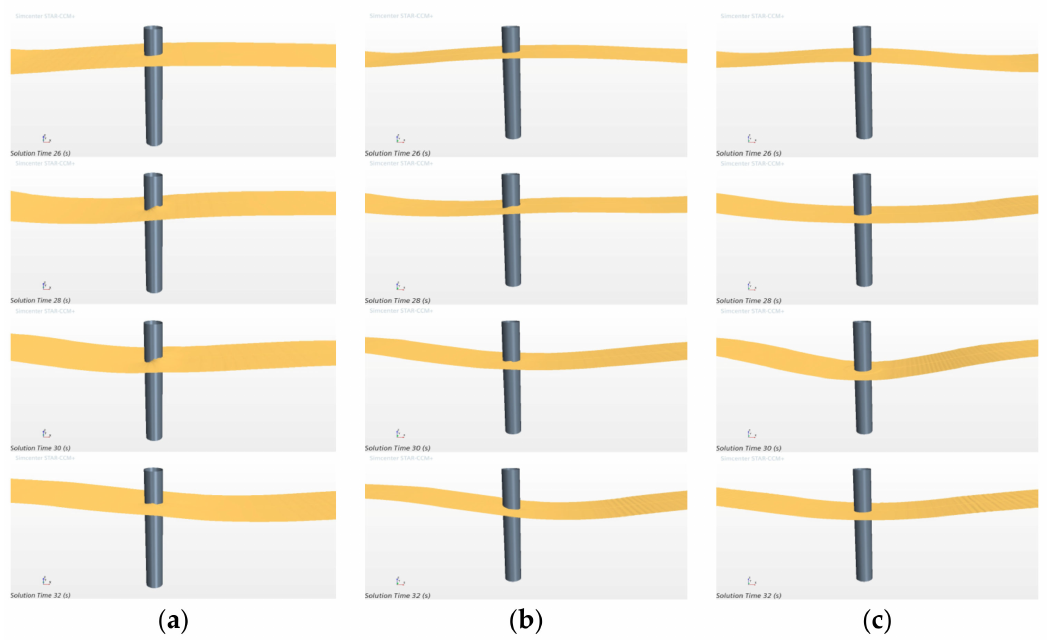
Figure 9. Wave surface analysis for ( a ) condition 1; ( b ) condition 3; and ( c ) condition